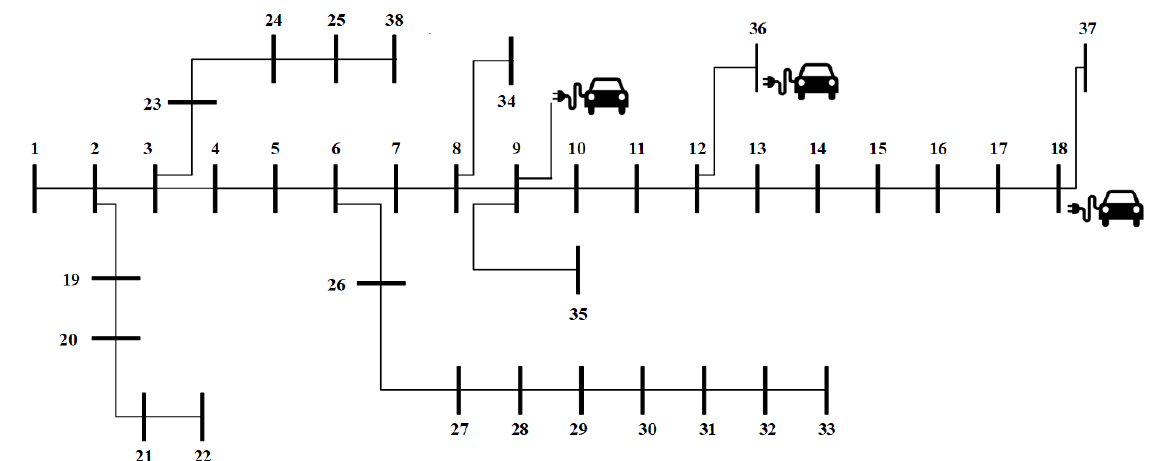
Figure 3. The 38-bus power distribution system under study.